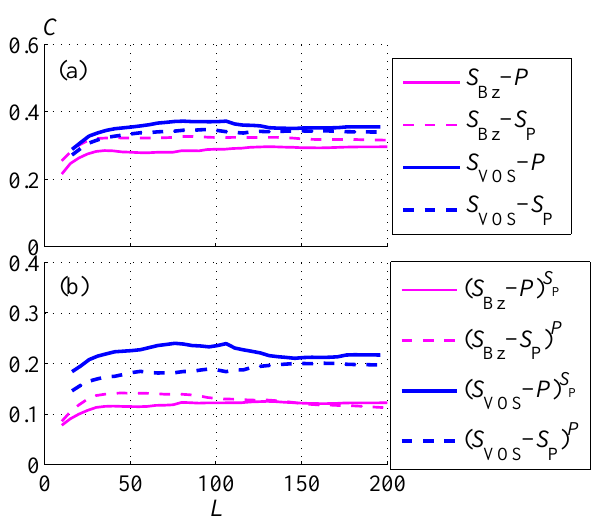
Fig. 4. (a) The same for the correlation between ULF power at VOS (blue) and WIND (magenta) and solar wind dynamical pressure P (solid) and amplitude of its fluctuation S P (dashed). (b) The same, but for “pure” components (orthogonal to the parameters given in the upper indexes).